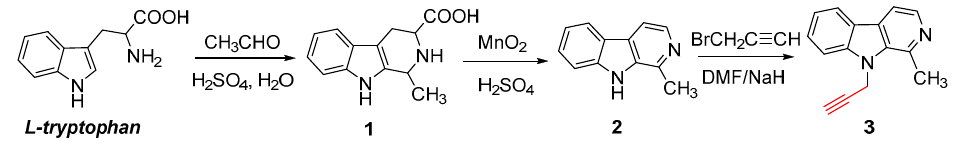
Figure 1. Designed strategy of aryl-1,2,3-triazole- β -carboline hybrids.